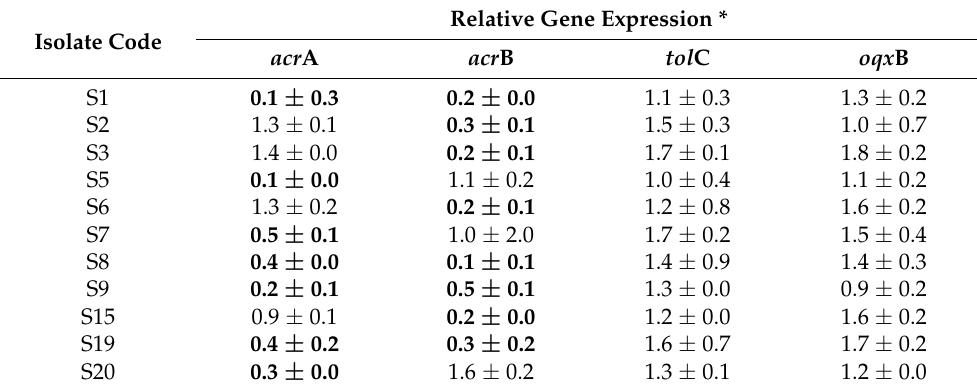
Table 3. The relative expression of the genes encoding the efflux pump activity in S. enterica isolates after treatment with CRME.